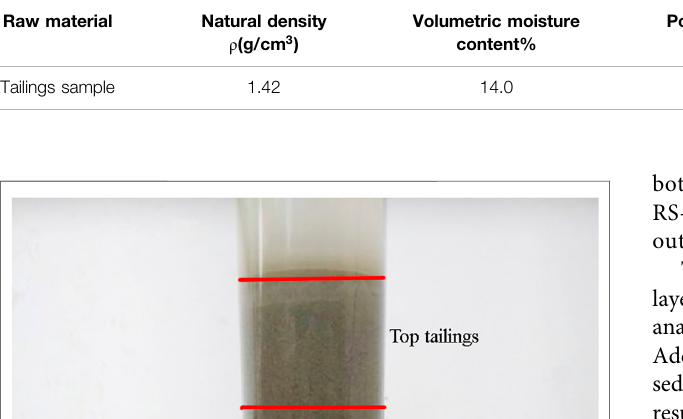
TABLE 1 | Physical properties of the fi ne-grained tailings.